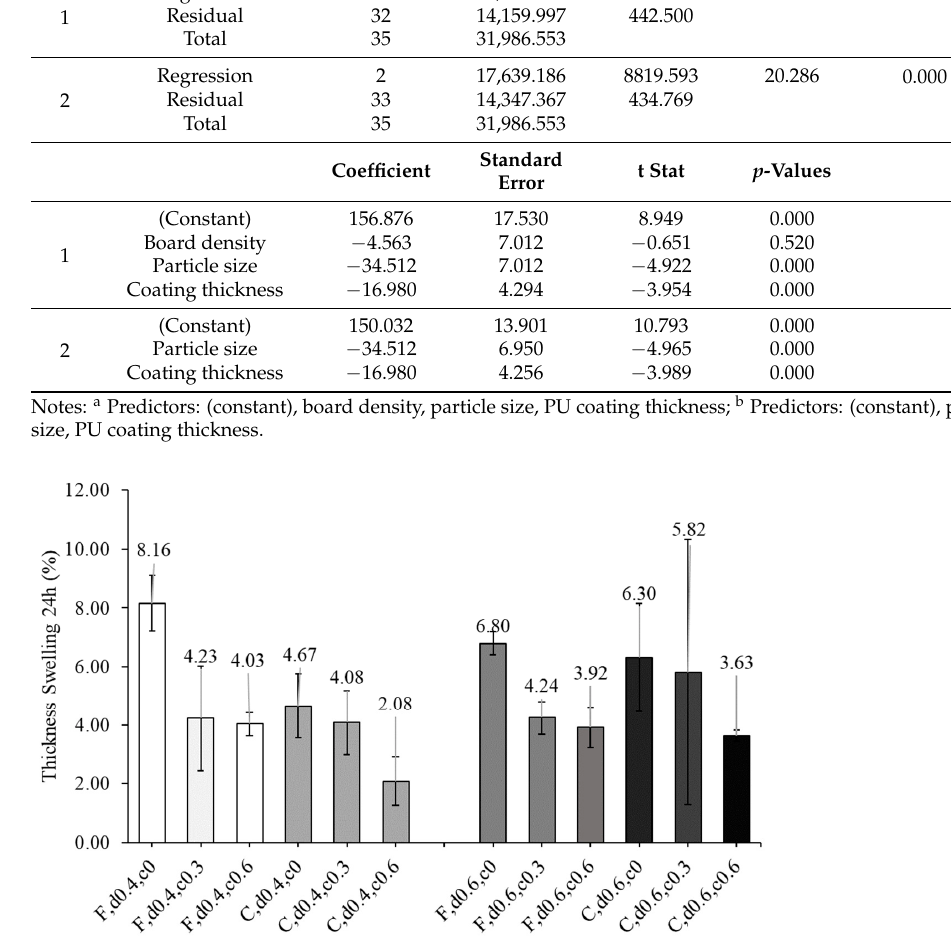
Figure 7. Thickness swelling (TS) 24 h values of bamboo particle board at various PU coating thickness with differences in particle size and board density.